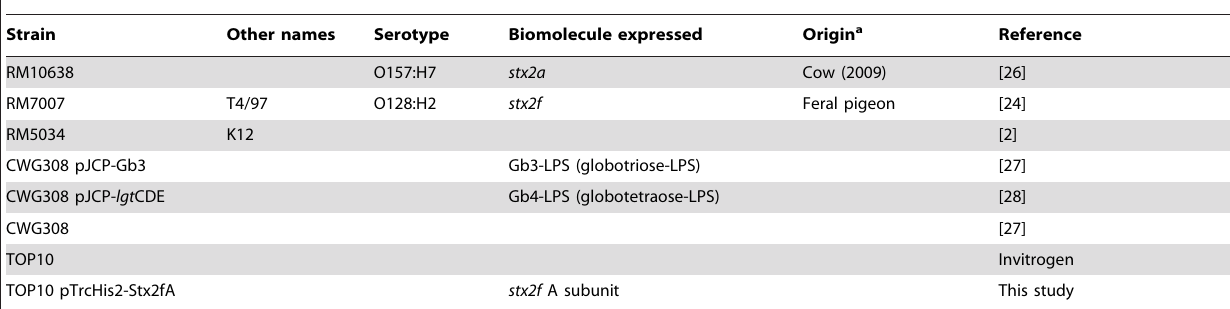
Table 1. E. coli strains used in this